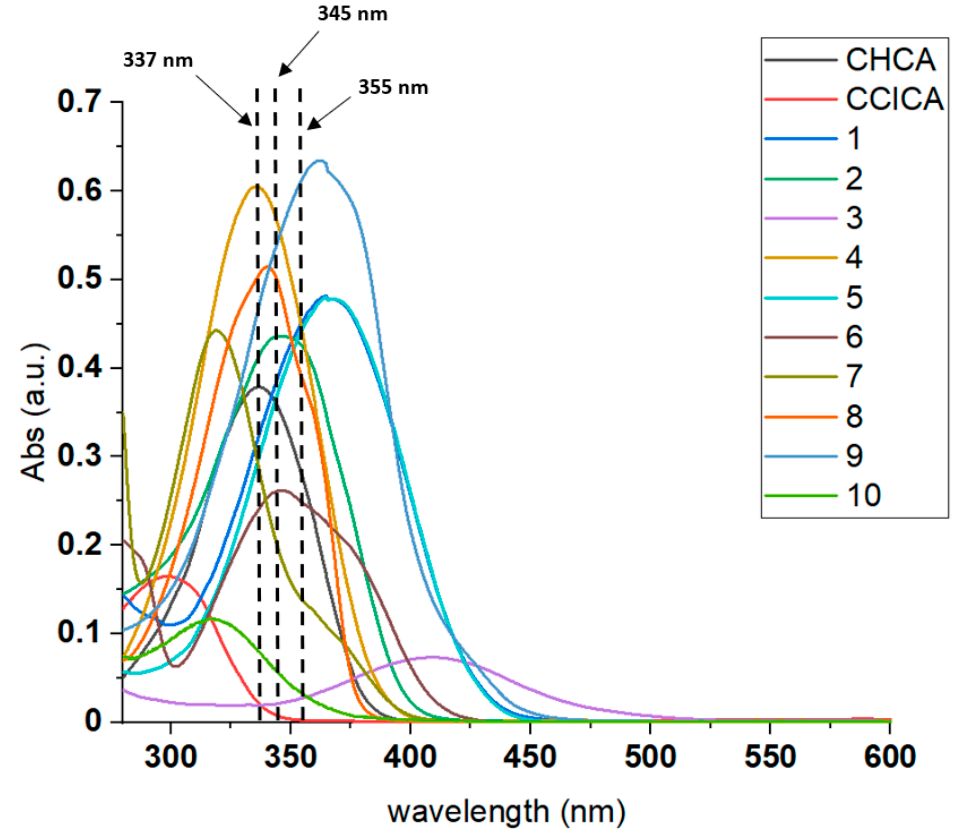
Figure 2. UV absorption spectra of investigated compounds ( 1 – 10 ) compared with CHCA and ClCCA. The laser wavelengths generally used in MALDI-MS at 337 nm (nitrogen), 345 nm (Nd:YLF), and 355 nm (Nd:YAG) are marked with vertical dotted lines.